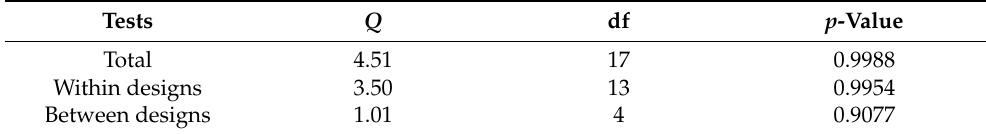
Figure 2. A network map of the meta-analyses (NMA). The connected lines show direct comparisons, and the unconnected lines show indirect comparisons. A wider line shows a larger number of field trials. Table 2. The Cochran’s Q test of heterogeneity (within designs) and inconsistency (between